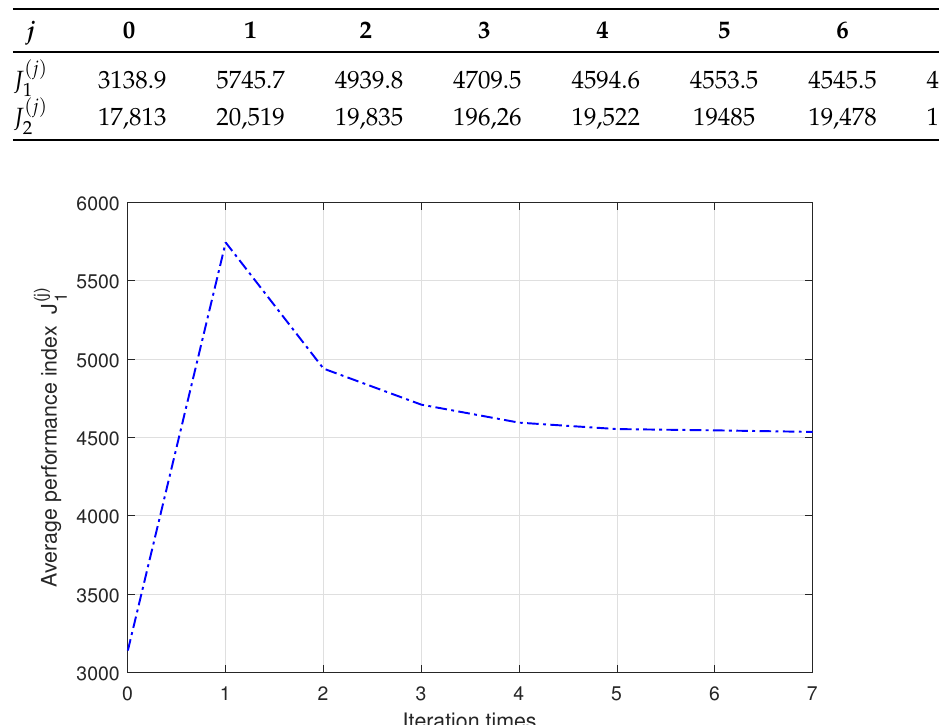
( j ) ( j ) for different iteration times j . and J 2 1